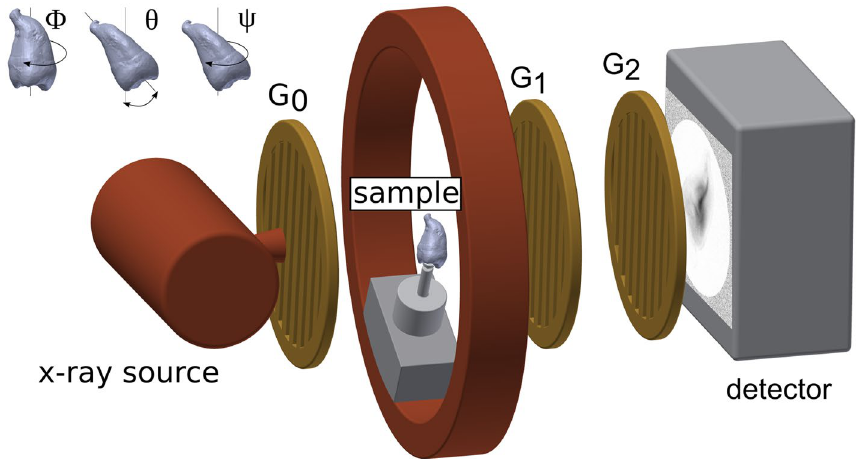
Figure 1. Schematic overview of the experimental setup, including a grating interferometer. The source grating G0 provides enough spatial coherence to generate a self-interference effect after the phase-grating G1. The subsequent modulation is recorded by a phase-stepping procedure with the attenuation grating G2 and yields the attenuation as well as information about the refractive index and small-angle X-ray